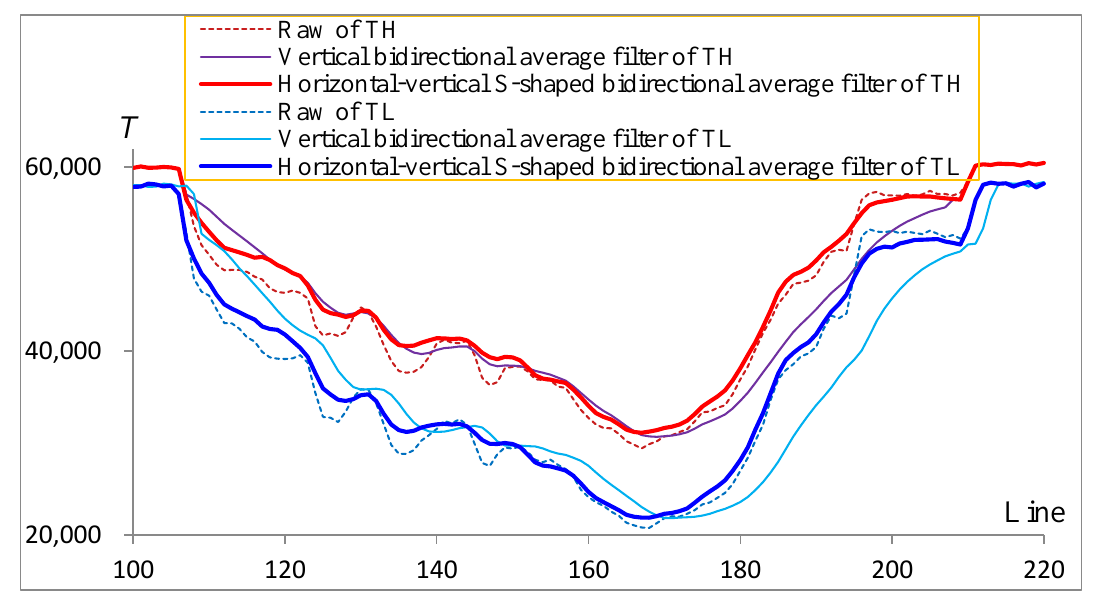
Figure 6. Comparison of filtering effects of a channel.